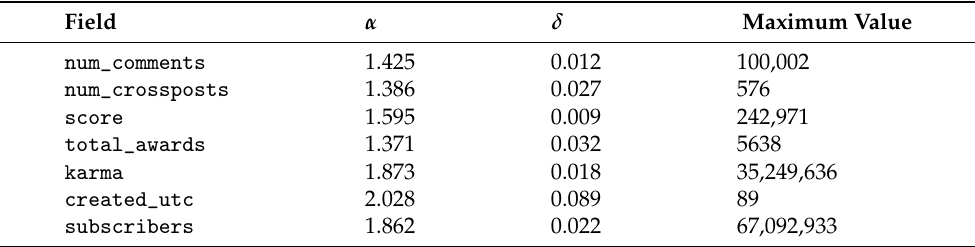
Table 4. Values of α and δ of the power law distributions and maximum values of the fields of interest for the eWoM Power